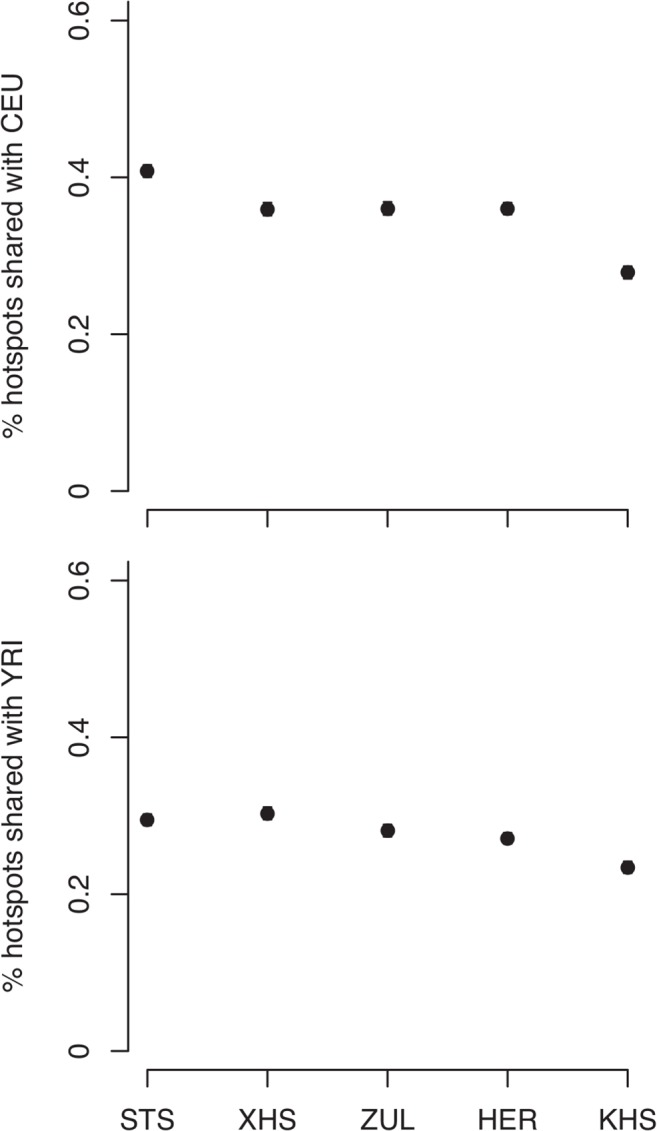
Proportion of shared recombination hotpots between the southern African and HapMap populations (CEU, YRI).